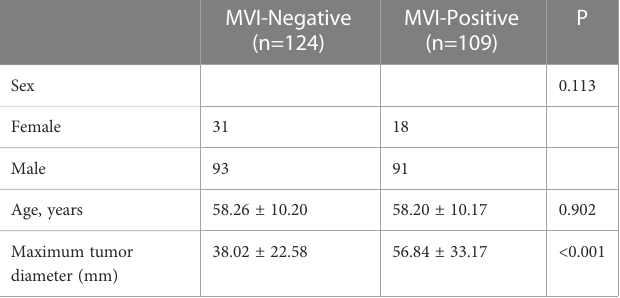
Table 3. FPS is a common metric used to evaluate the speed of a model, and it indicates the number of images that the model can process per second. The FPS for the 2D-DL model (based on 2D- ResNet) is 244.7566, which is much larger than that of the 3D-DL model (73.3374).